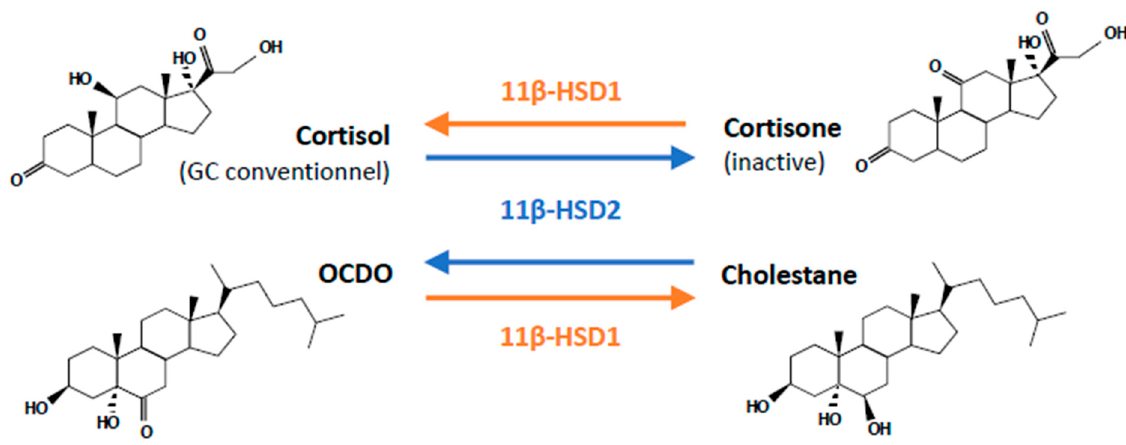
Figure 2. Structure of natural GR ligands. The natural form of glucocorticoid is cortisol that can be converted into inactive cortisone by the 11 β -HSD2 enzyme. The same enzyme metabolizes cholestane-3 β ,5 α ,6 β -triol (CT) into 6-oxo-cholestan- 3 β ,5 α -diol (OCDO).